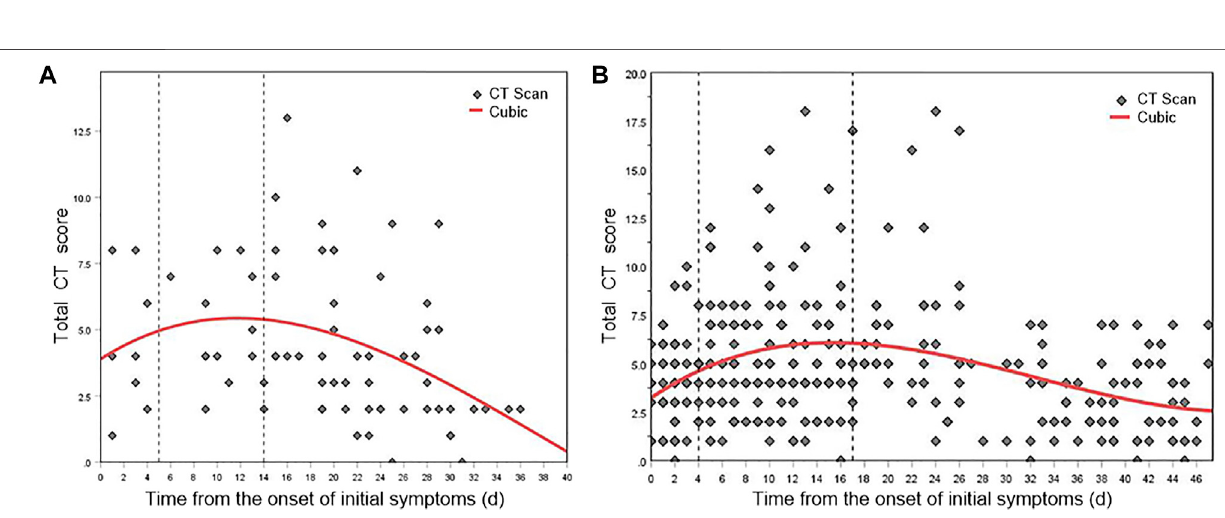
FIGURE 6 | Mean dynamic trends in lung involvement since the onset of initial symptoms (quanti fi ed by total CT scores). (A) Total CT score distribution and fi tting curve of Original COVID-19 patients. (B) Total CT score distribution and fi tting curve of Delta Variant patients.